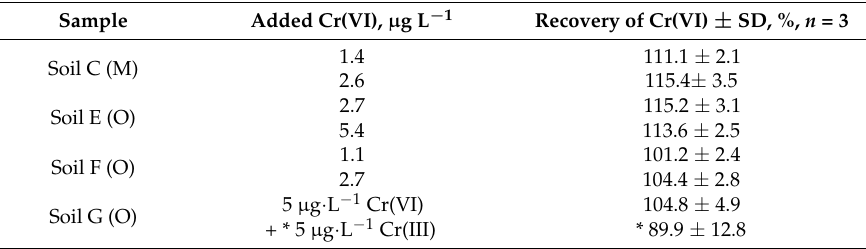
Table 4. The recovery of Cr(III) and Cr(VI) spikes from various type of soil determined by IP RP HPLC-ICP MS